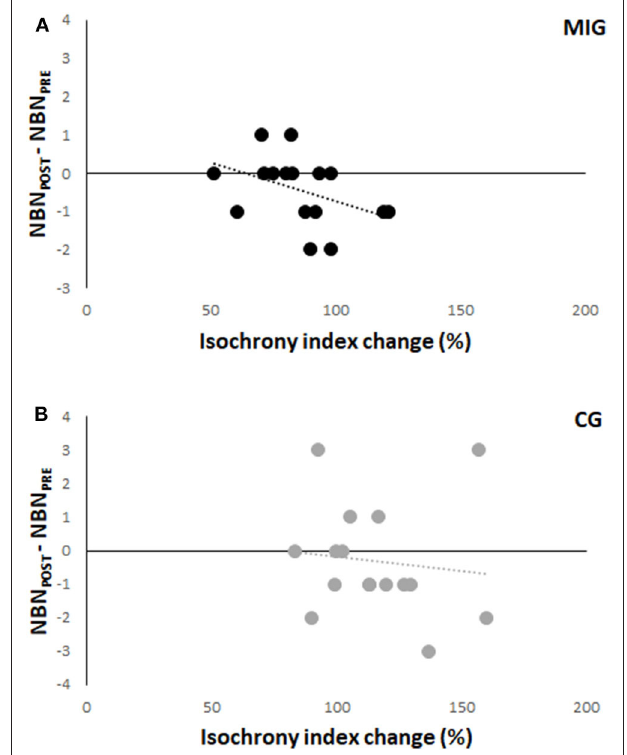
FIGURE 3 | Relationship between the difference from baseline to after the training period in the number of ball that passed over the net (NBN POST -NBN PRE , y-axis), and the percentage changes in isochrony index (x-axis) in Motor Imagery Group [MIG, (A) ] and Control Group [CG, (B) ]. Each circle represents the data of a one